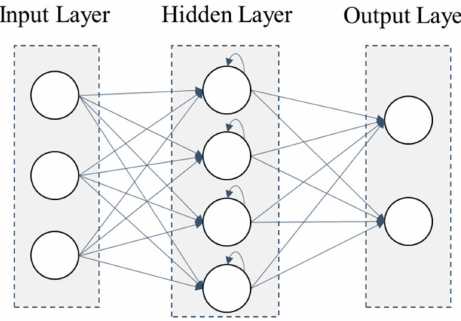
Figure 3. Convolutional neural network (CNN)